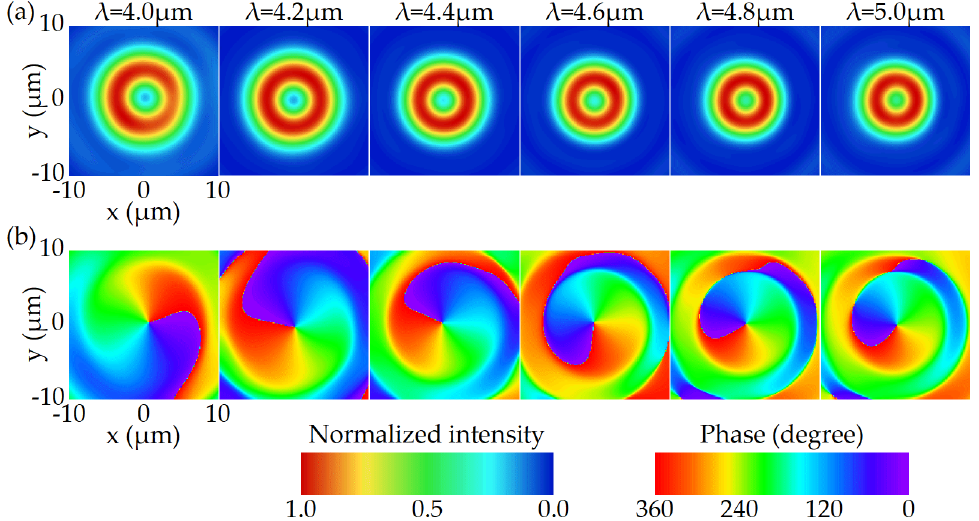
Figure 9. The simulated electric field distribution for the FVBG with hyper-negative dispersion on the focal plane between 4.0 and 5.0 μ m. ( a ) Normalized intensity. ( b ) Phase.